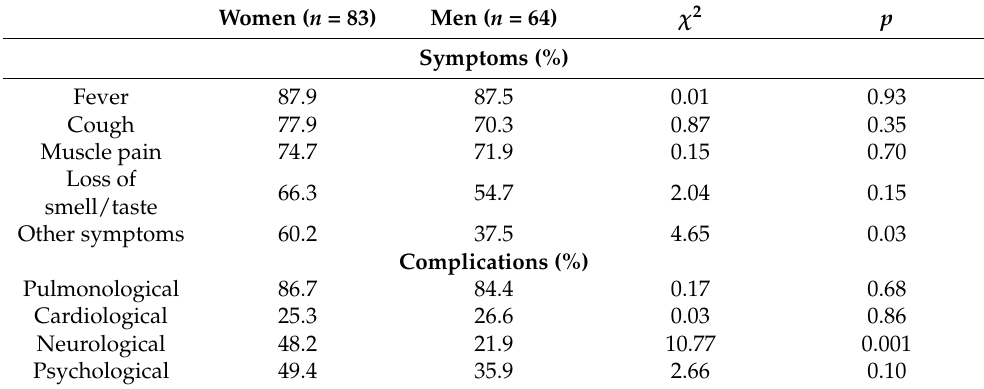
Table 2. Percentage of incidence of symptoms and complications by gender, including statistical analyses. Women ( n = 83) Men ( n = 64) χ